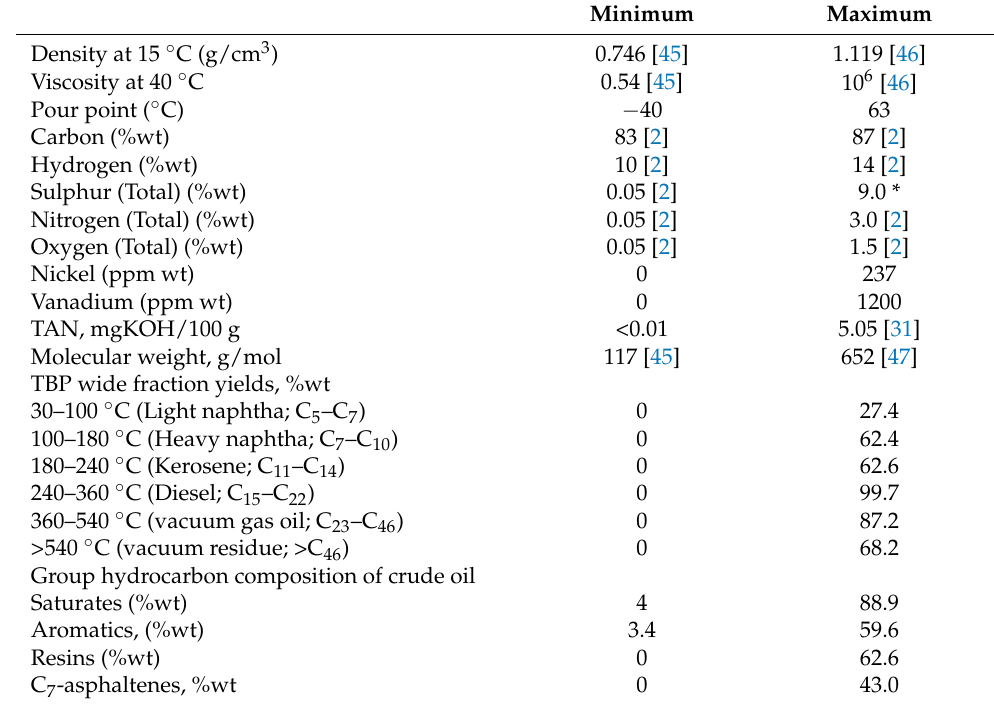
Table 1. Range of variation of bulk properties of crude